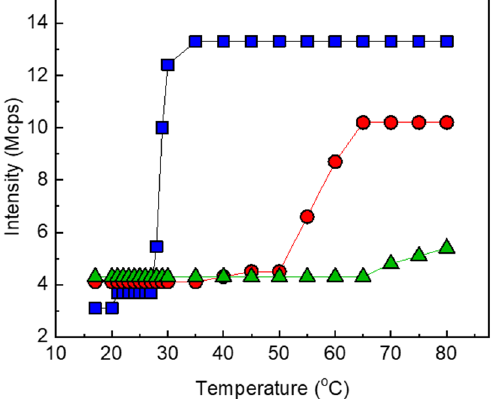
Figure 4. Light scattering intensity at 90° as a function of temperature of PLL-g-NIPAm87, C p = 1 wt%, in aqueous solutions at various pH: ( □ ) pH 11.6, ( ○ ) pH 9, ( ∆ ) pH 8.